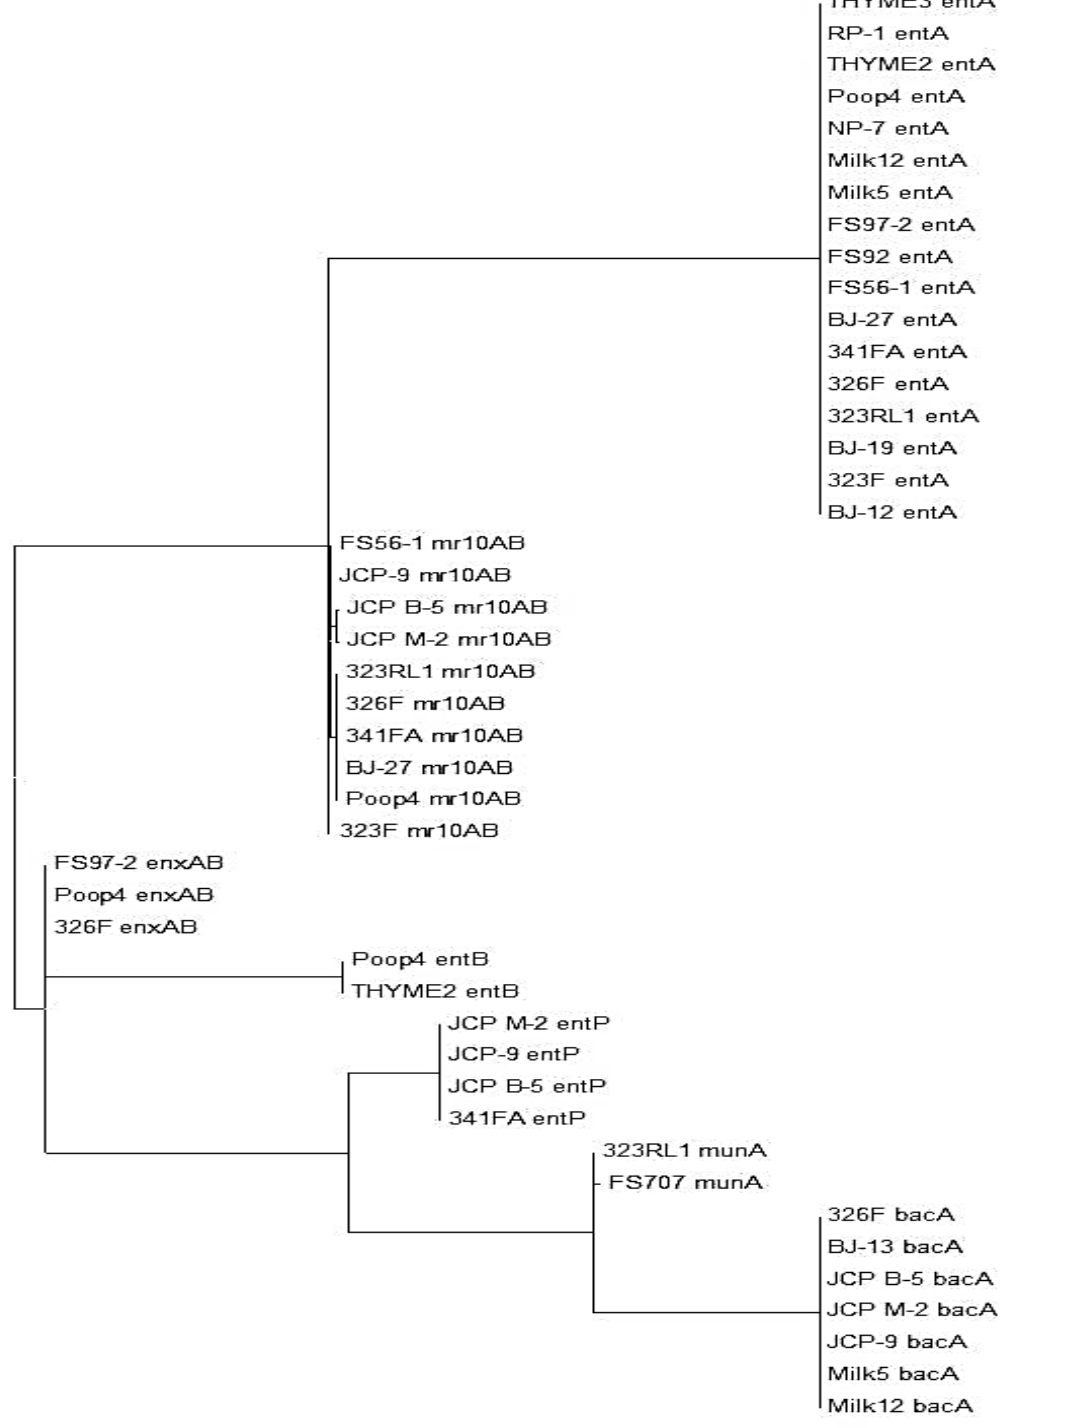
Figure 3. Maximum likelihood homology tree obtained from multiple sequence alignment and phylogenetic analysis of all bacteriocin-related sequences from the Enterococcus strains examined in this study. The bacteriocin name appearing after the strain designation is indicative of the enterococcal bacteriocin to which the amplimer had the highest